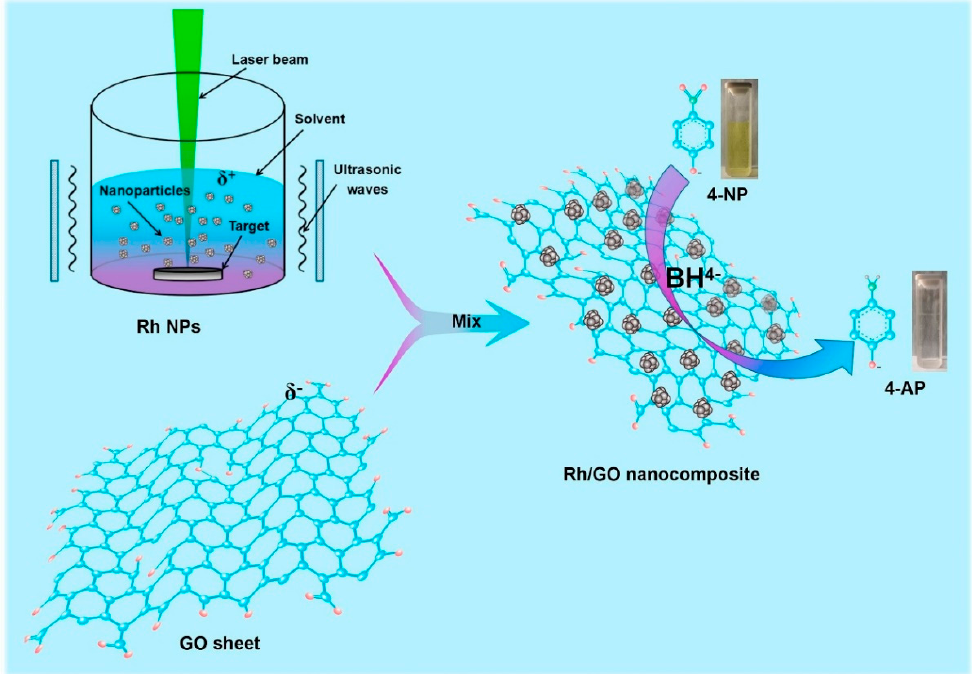
Figure 6. The schematic diagram of the preparation of Rh/GO nanocomposite and the catalytic reduction of 4-nitrophenol to 4-aminophenol. Reprinted with permission from Ref. [54].